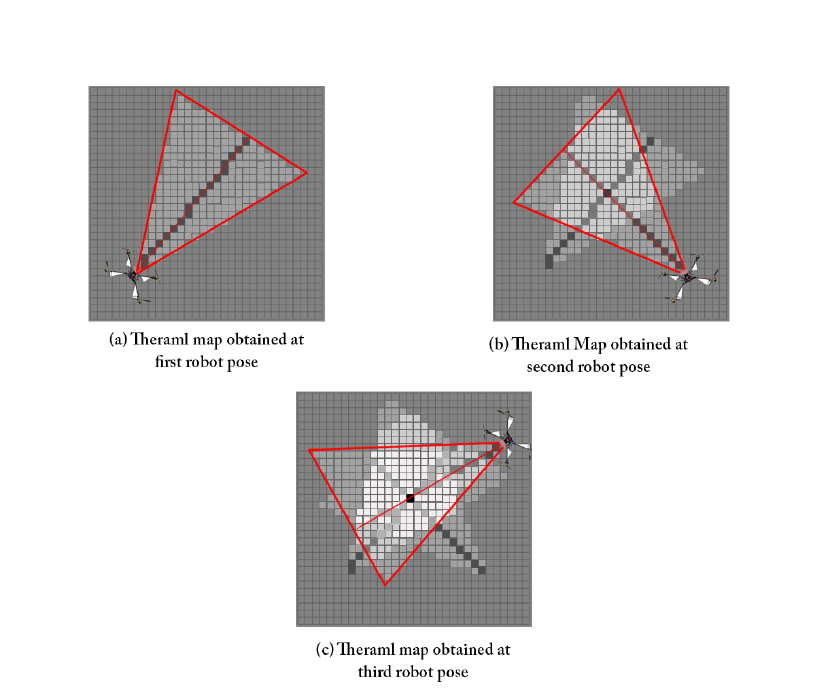
Figure 5. Thermal map update for three different robot